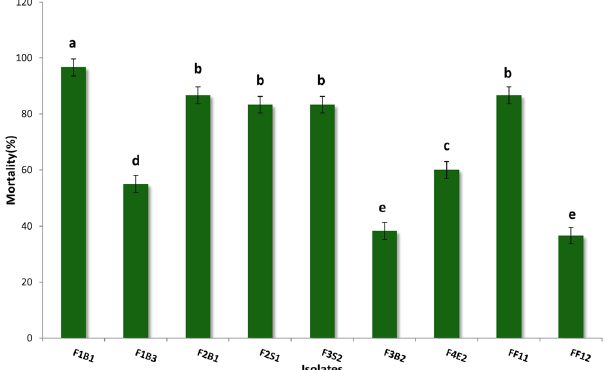
Figure 3. Mortality of tilapia fish ( Oreochromis niloticus ) exposed to fish pathogenic E . faecalis isolates in the laboratory conditions. One way ANOVA was performed for analyzing the data of three replicated experiment and data in column varies significantly in LSD at p ≤ 0.05. Different letter bars indicates significant variations in mortality of fish in different groups by the E . faecalis isolates at p ≤ 0.05.